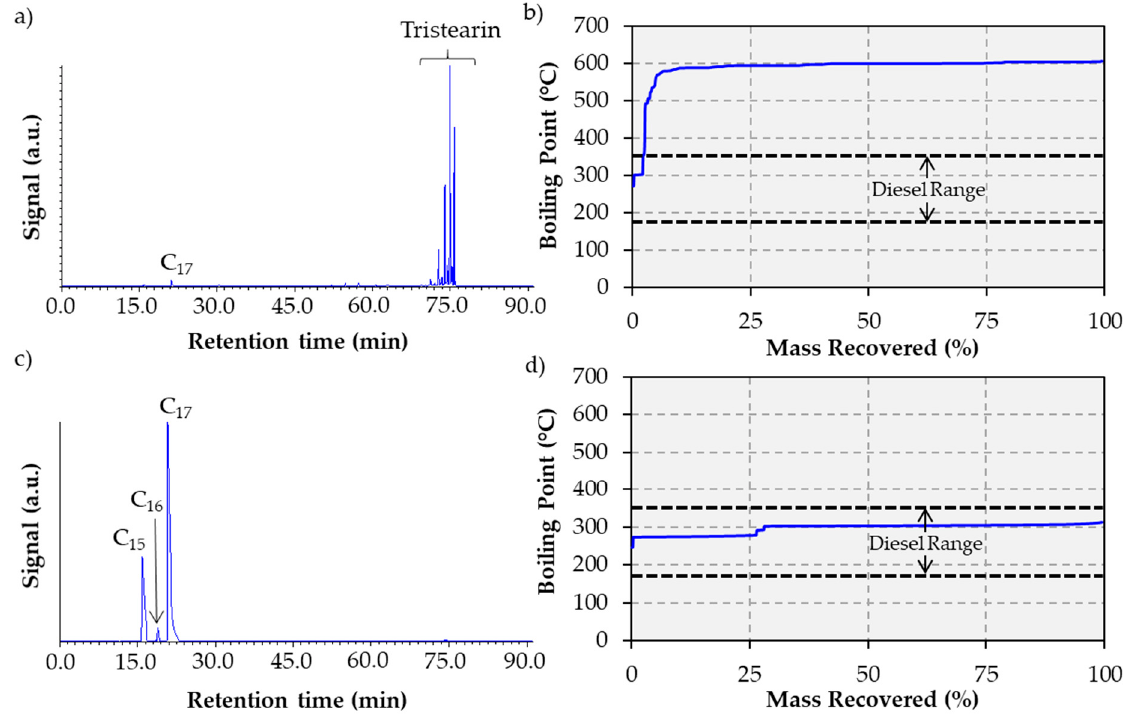
Figure 6. Gas chromatograms and BPDPs of the liquid products collected from the deoxygenation of tristearin with 20% Ni/Al 2 O 3 ( a and b ) and 20% Ni-0.5% Pt/Al 2 O 3 ( c and d ).